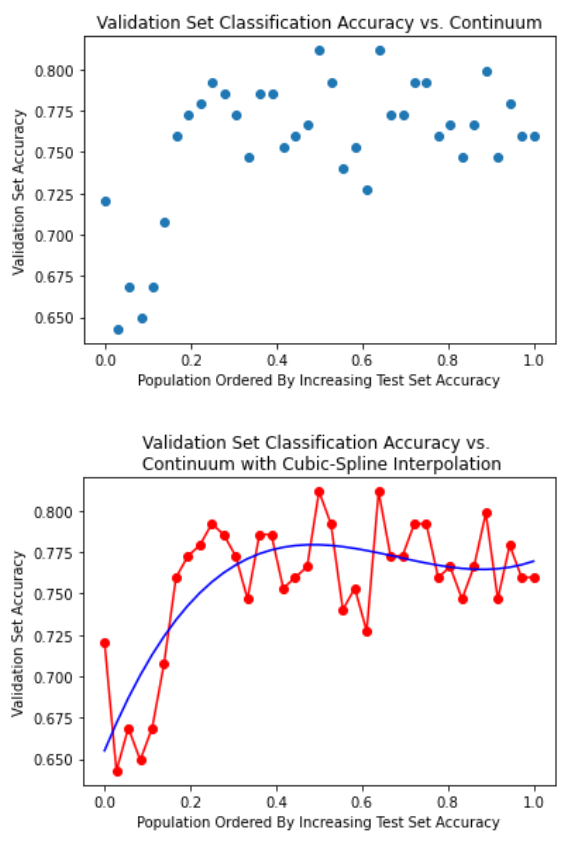
Figure 6. Validation set Classification